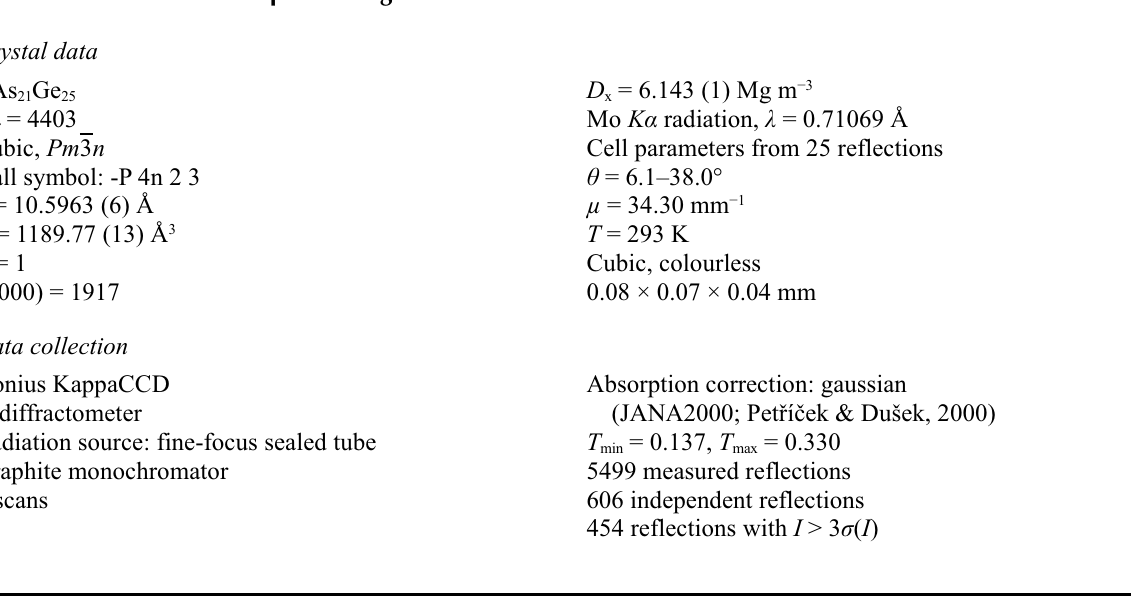
Figure 1 Projection de la structure de I Germanium (en gris), avec un déplacement des ellipsoīdes à 90% de probabilité. octaiodine henacosarsenic